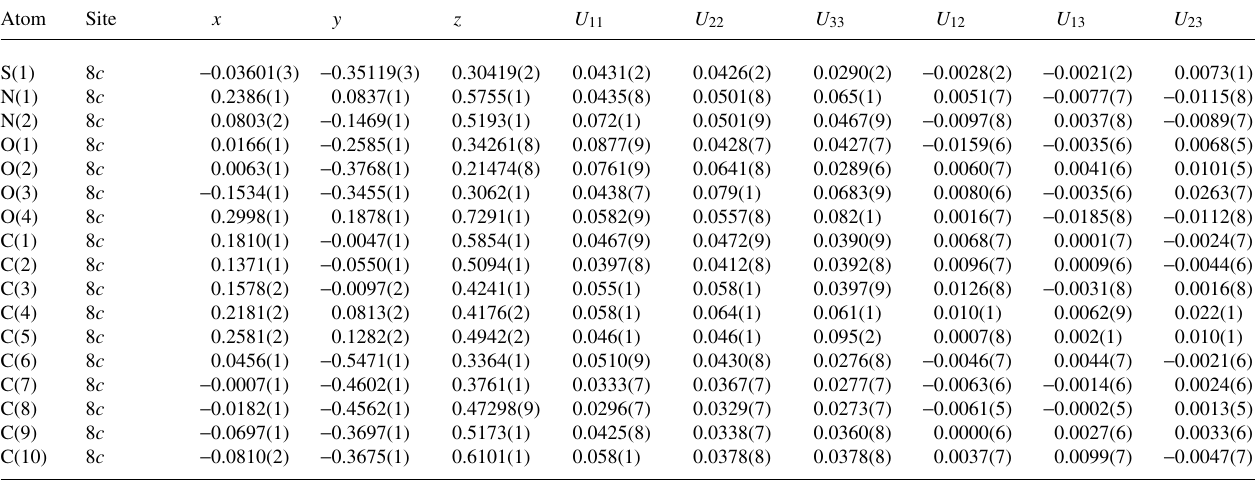
Table 3. Atomic coordinates and displacement parameters (in Å 2 ) .